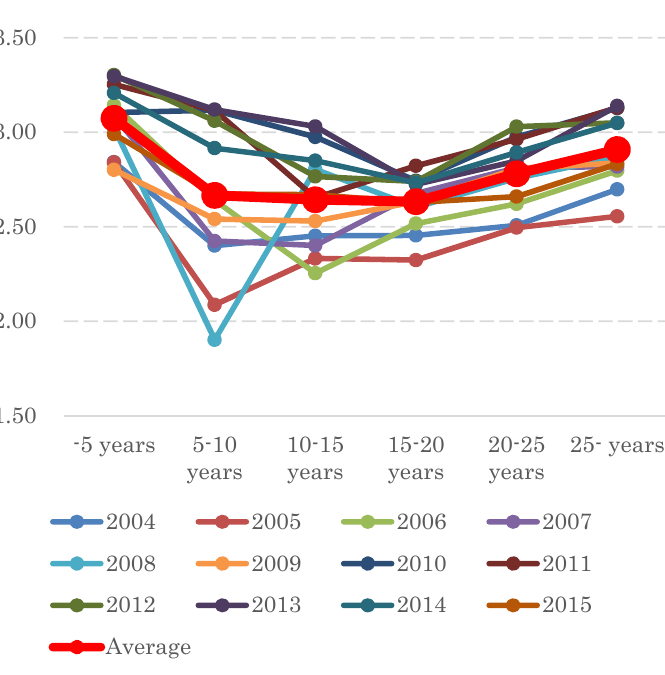
Figure 1. Years of service and perspective index